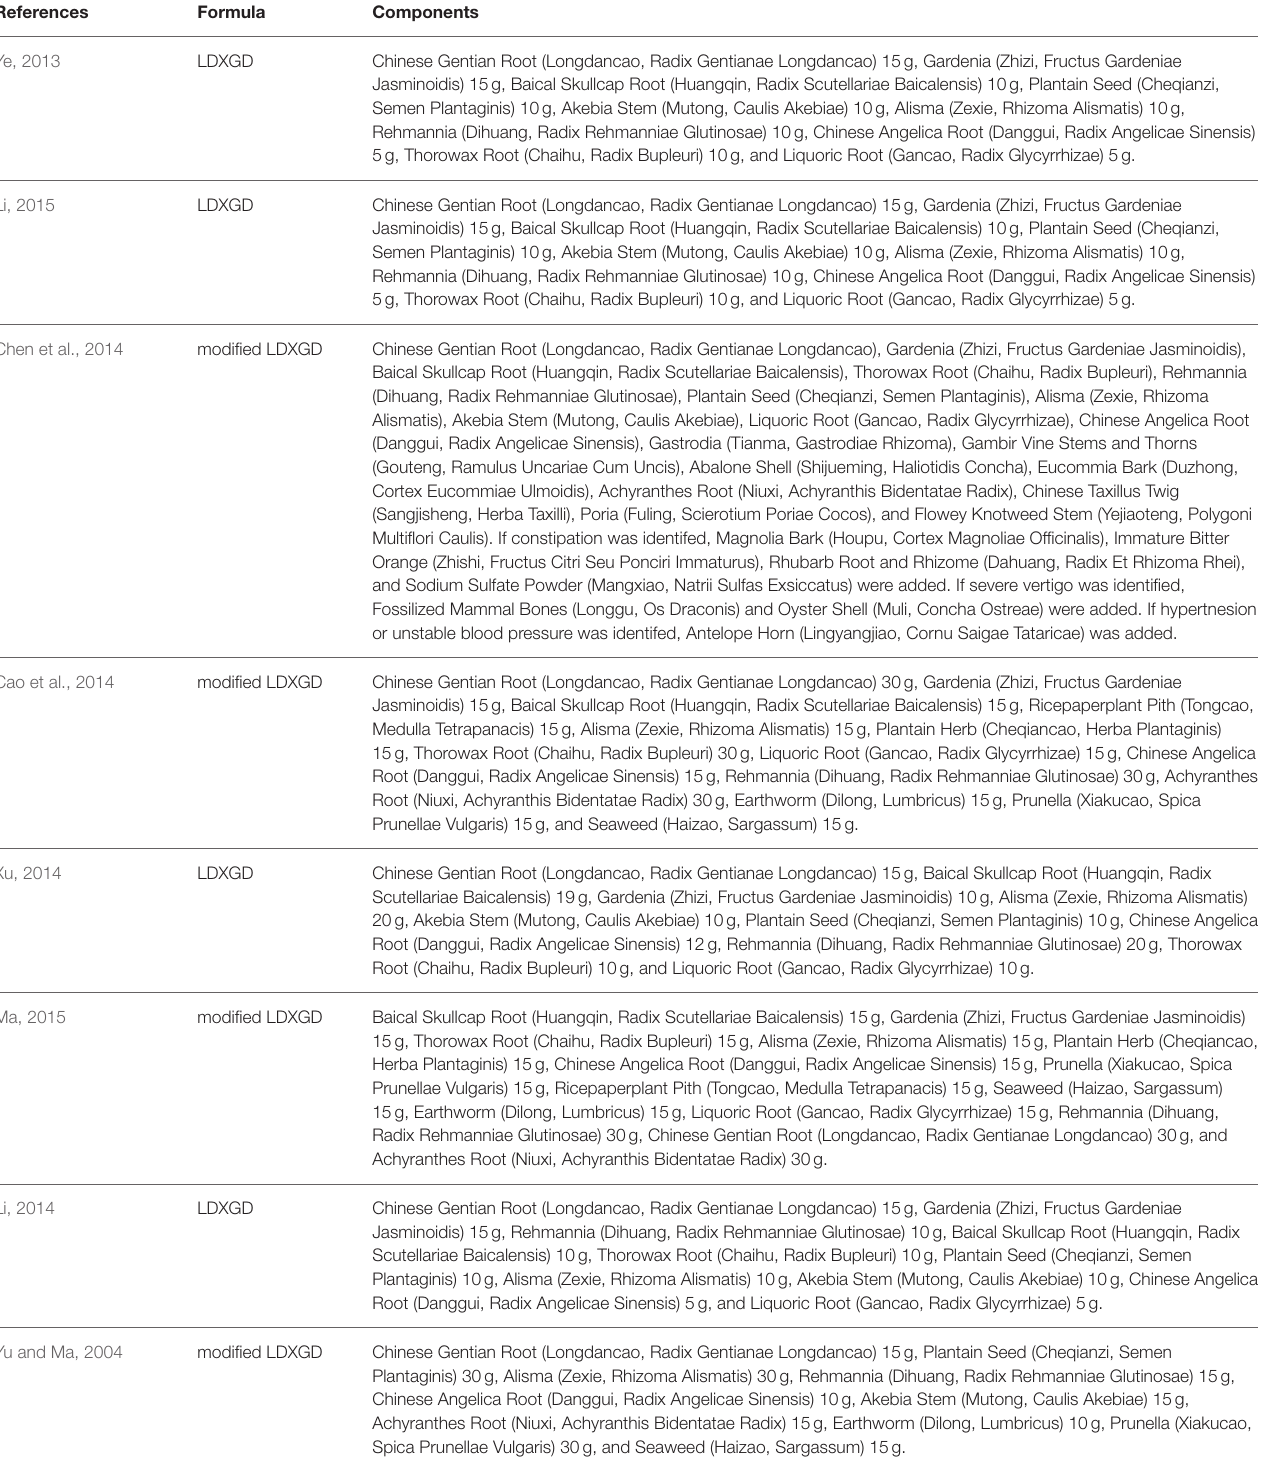
TABLE 2 | Components of Chinese herbal formulas used in the included